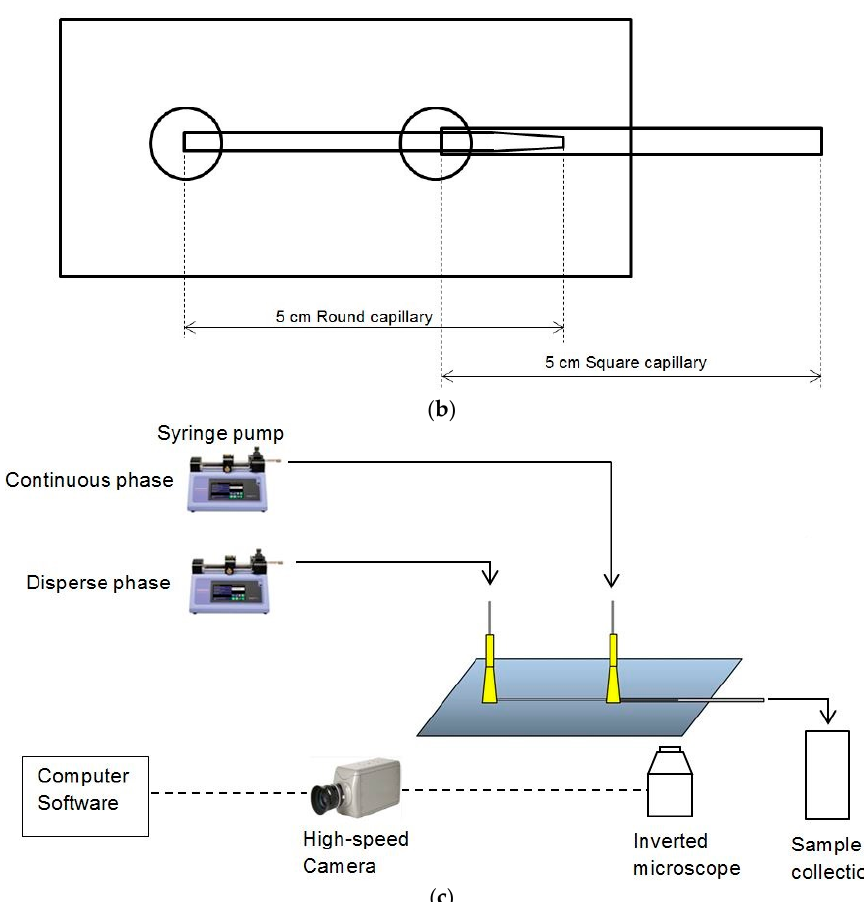
Figure 1. ( a ) Schematic diagram of a co-flow glass capillary device used in the study and a magnified schematic diagram of the co-flow region in the device; ( b ) top view of the device; and ( c ) schematic diagram of the experimental set-up for co-flow microfluidic experiments.